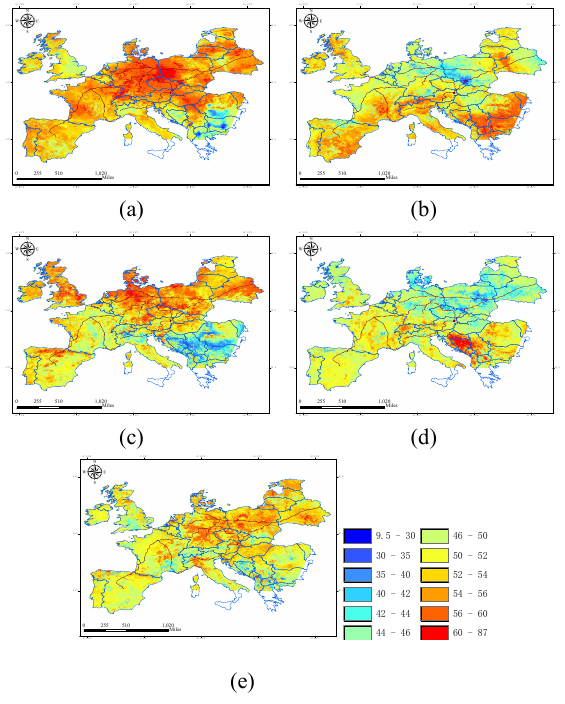
Fig. 2. CEI derived from 2010 to 2018: (a) 2008-2010, (b) 2010-2012, (c) 2012-2014, (d) 2014-2016, (e) 2016-2018. 4.2. Mean CEI Values Comparison between S1 and S2 Fig. 3 and 4 show the mean CEI values, which belong to S1 and S2 respectively, with the X-axis showing the countries involved in the different scales, and the Y-axis corresponding to the mean CEI values of different